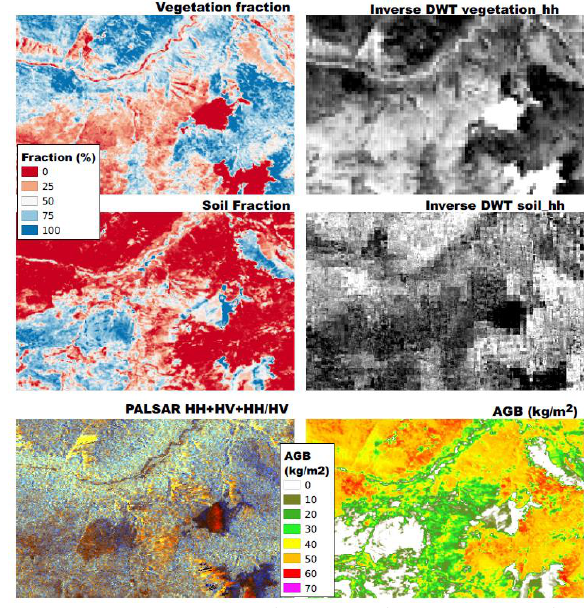
Figure 6. Intermediate and final results from application of mixing optical and SAR data with wavelet as in (Basuki et al., 2013).